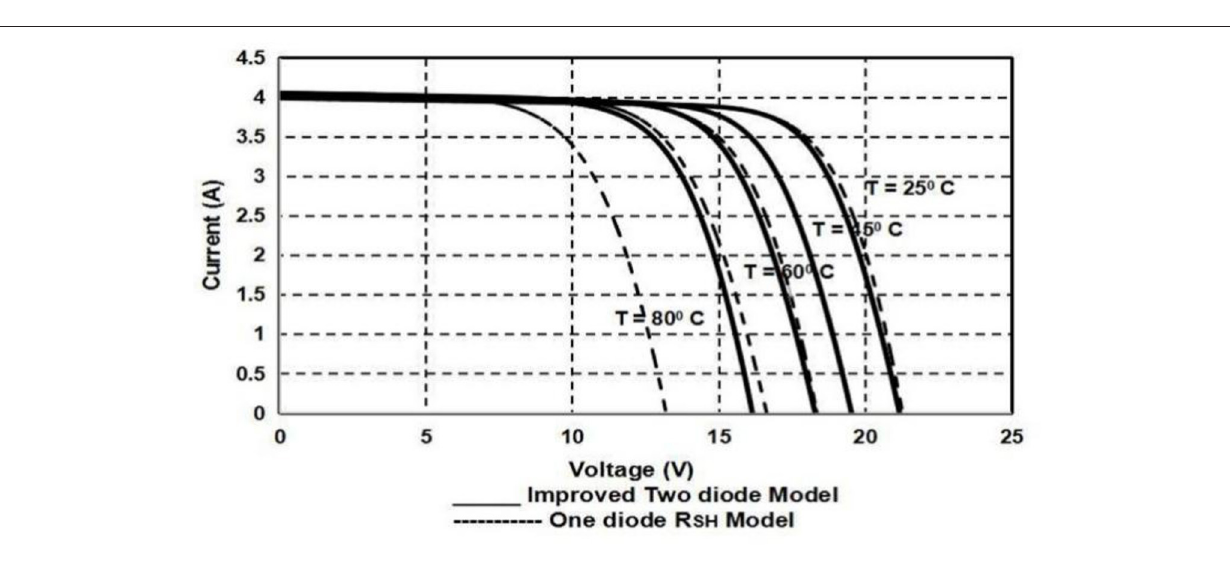
FIGURE 13 | Comparative analysis of current (A) vs. voltage (V) curve for one-diode R SH and proposed two-diode model for MSX-64 with different temperature points at STC (1,000 KW/m 2